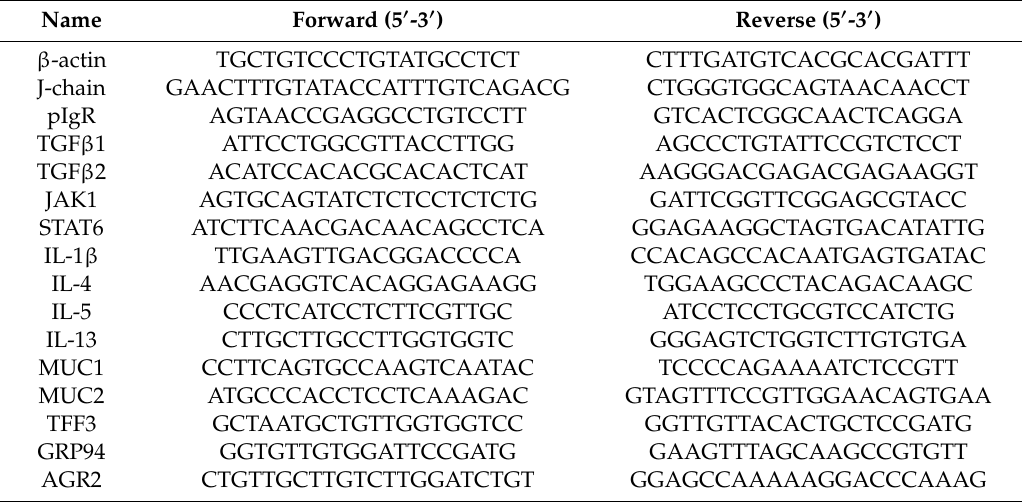
Table 3. Primers for